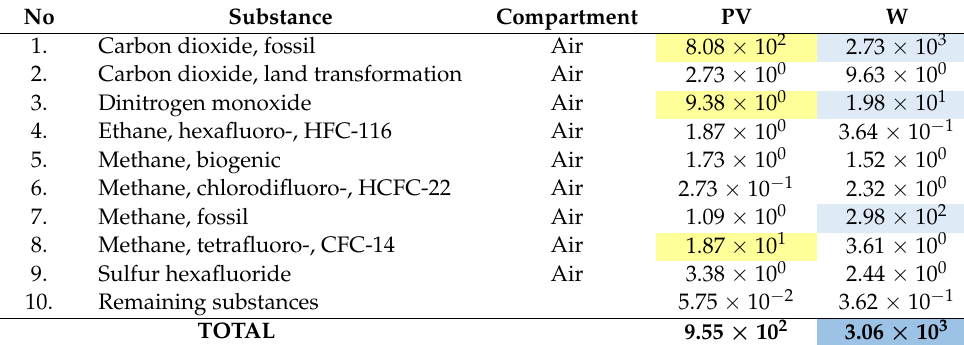
Table 3. Grouping and weighting results of environmental effects for global warming, terrestrial ecosystems present in the life cycle of wind (W) and photovoltaic (PV) power plants (unit: Pt).